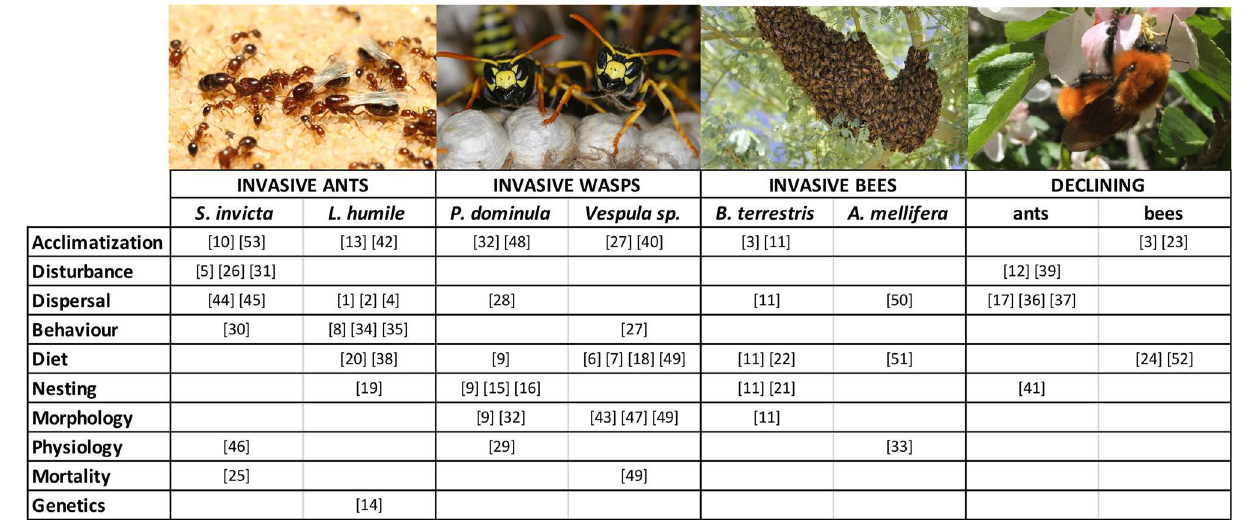
Frontiers in Ecology and Evolution |